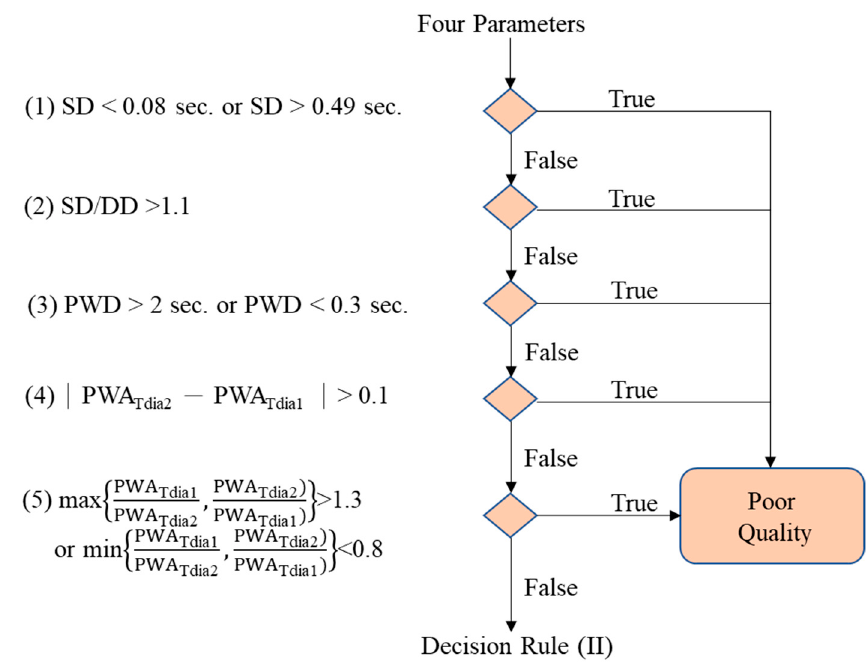
Figure 5. The decision rule (I). If any one rule is true, the pulse is poor quality.